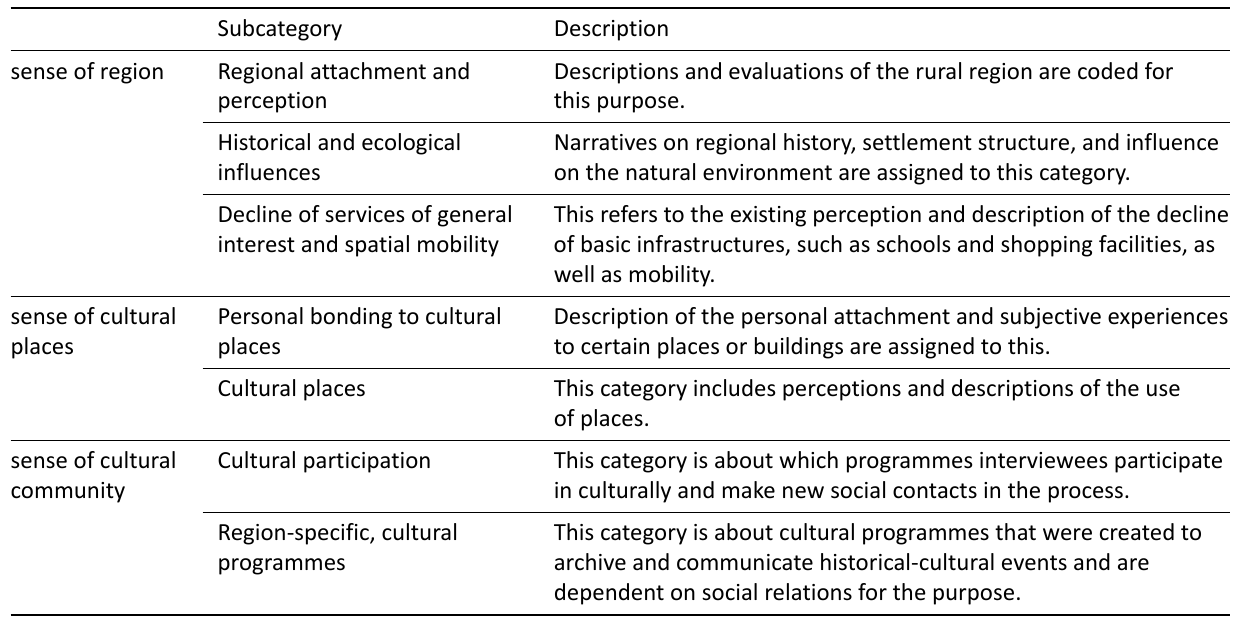
Table 1. Summary of the